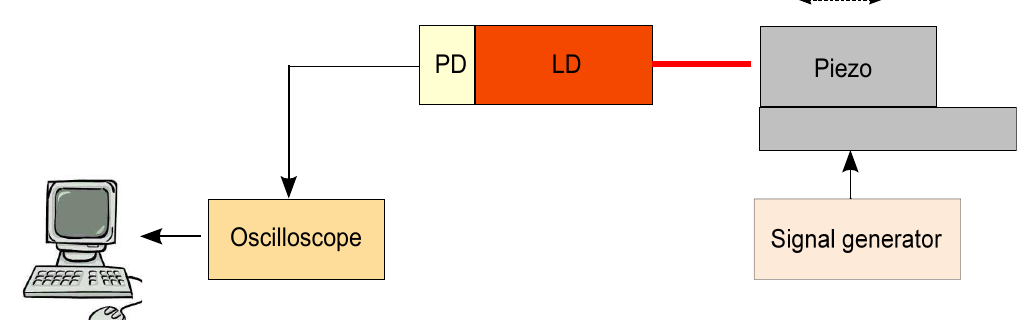
Figure 1. Experimental setup for the monitoring of transient path changes.